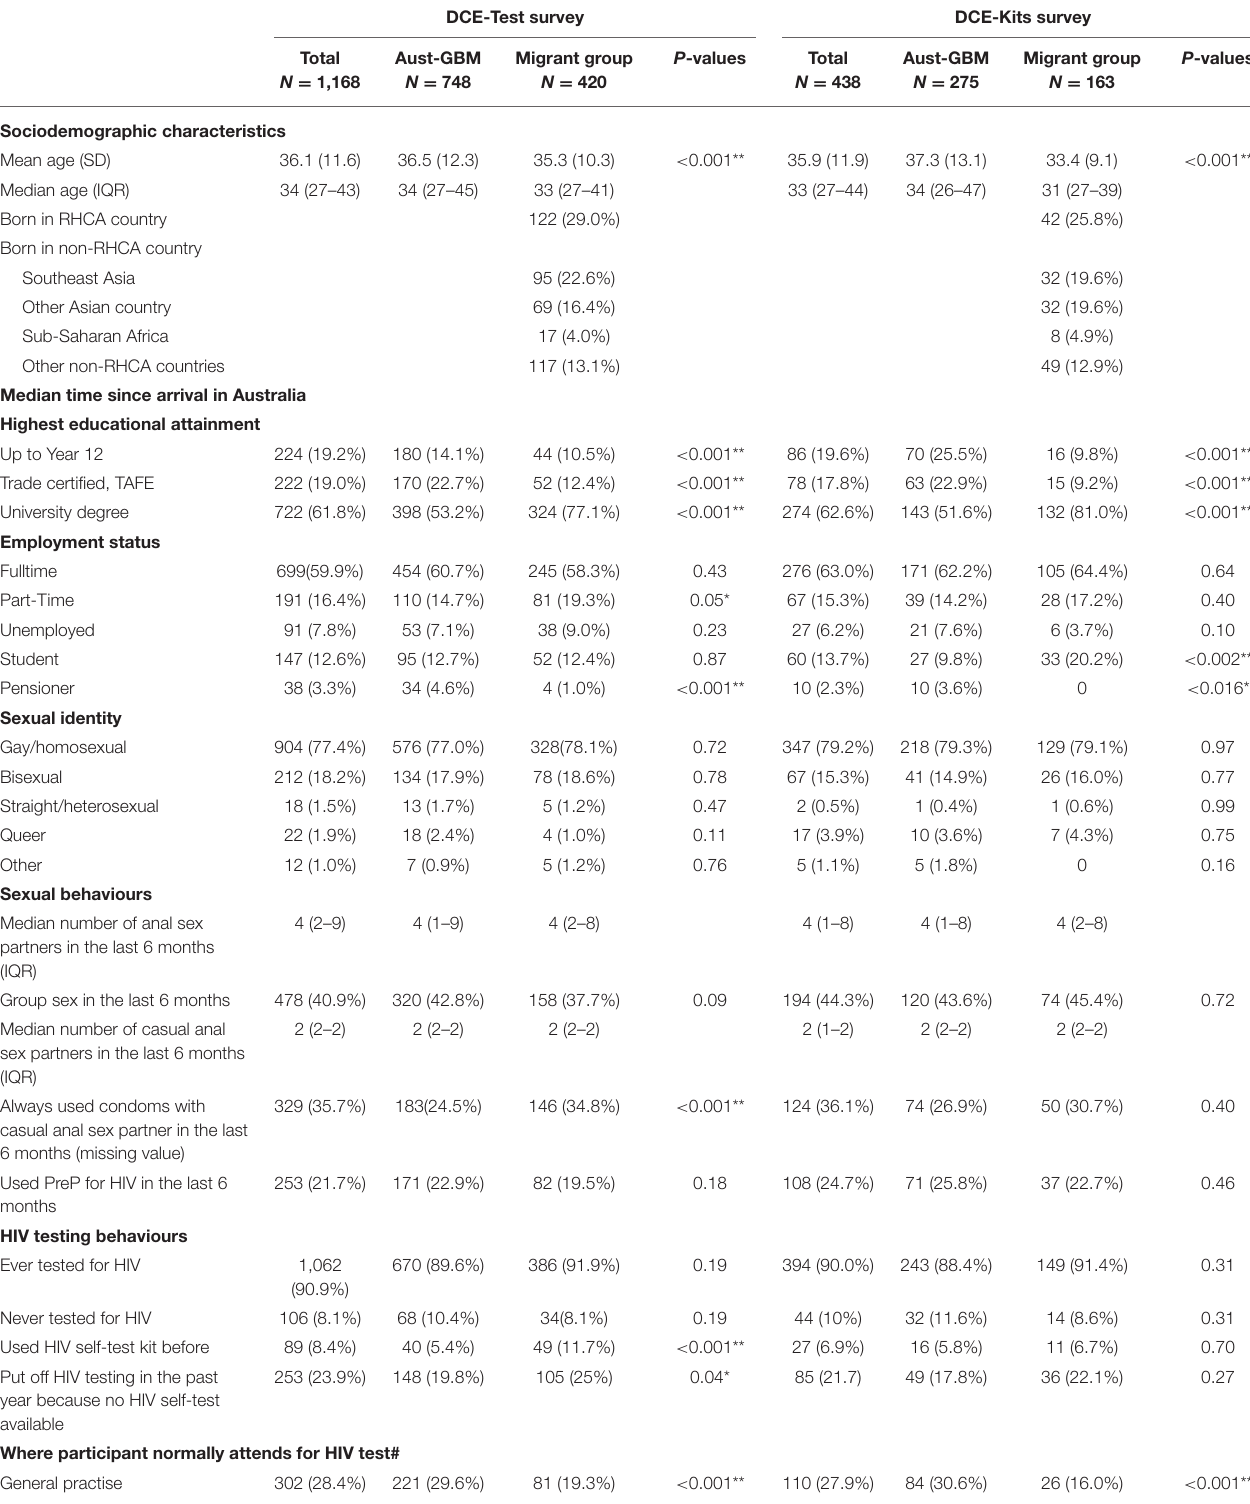
TABLE 1 | Sociodemographic characteristics of all respondents completing DCETest (HIV testing method) and DCEKits (HIVST access), 2018 ( N = 1,606) compared with Australia born GBMSM and migrant